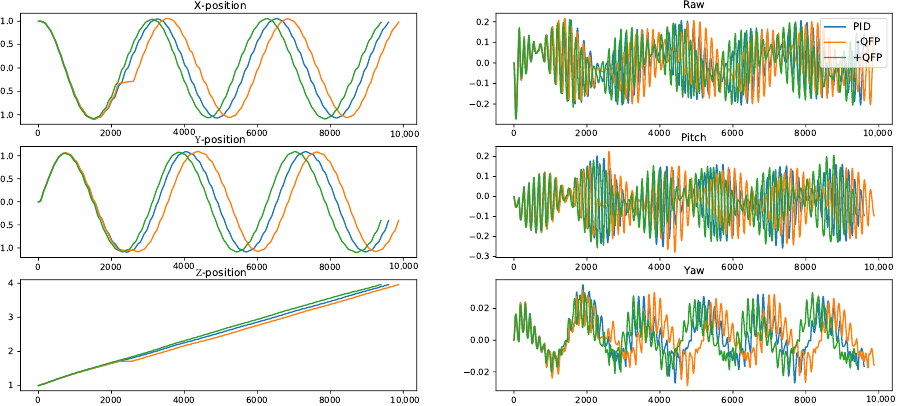
Figure 10. The position and the attitude angles of the quadrotor of the up-trajectory with circular wind type. The X-axis is the time step. The CFA+QFP model reached the last waypoint first.